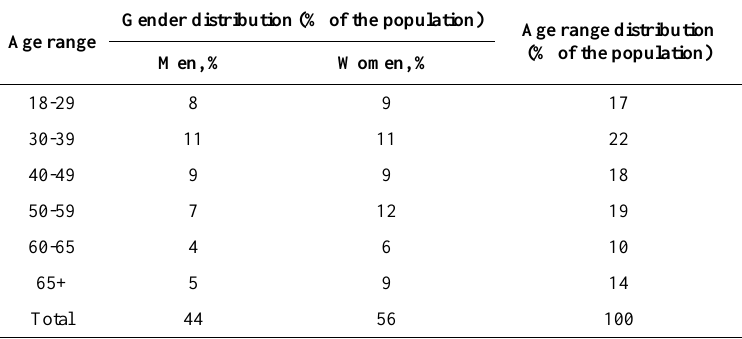
Table 1. Segments of quotation in the online survey for each administrative district of